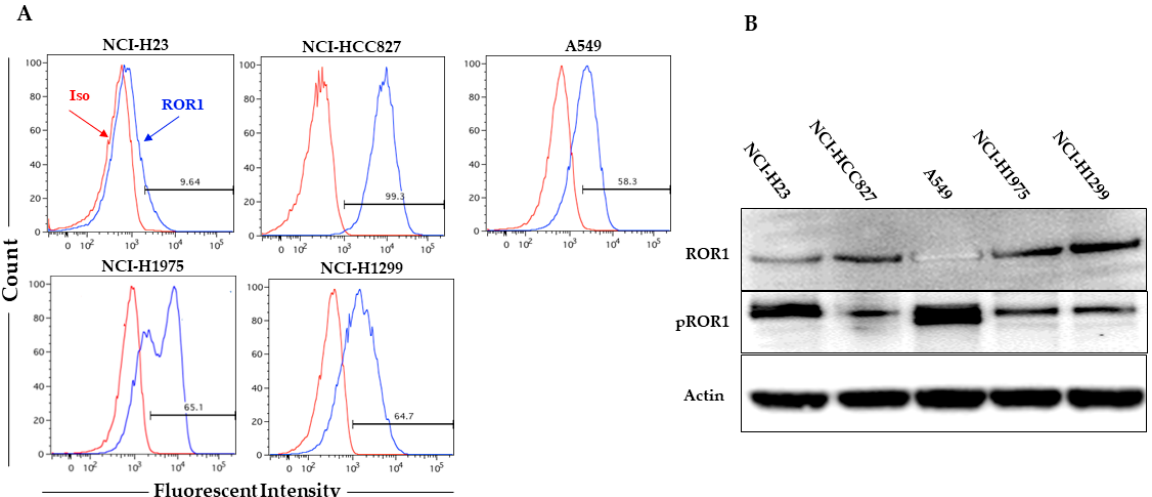
Figure 1. ( A ) Surface staining for ROR1 (flow cytometry) (red line: isotype control; blue line: anti- ROR1 antibody); ( B ) Western blot for ROR1 and pROR1 expression (130 KDa) in 5 lung cancer cell lines. Actin was used as internal control.